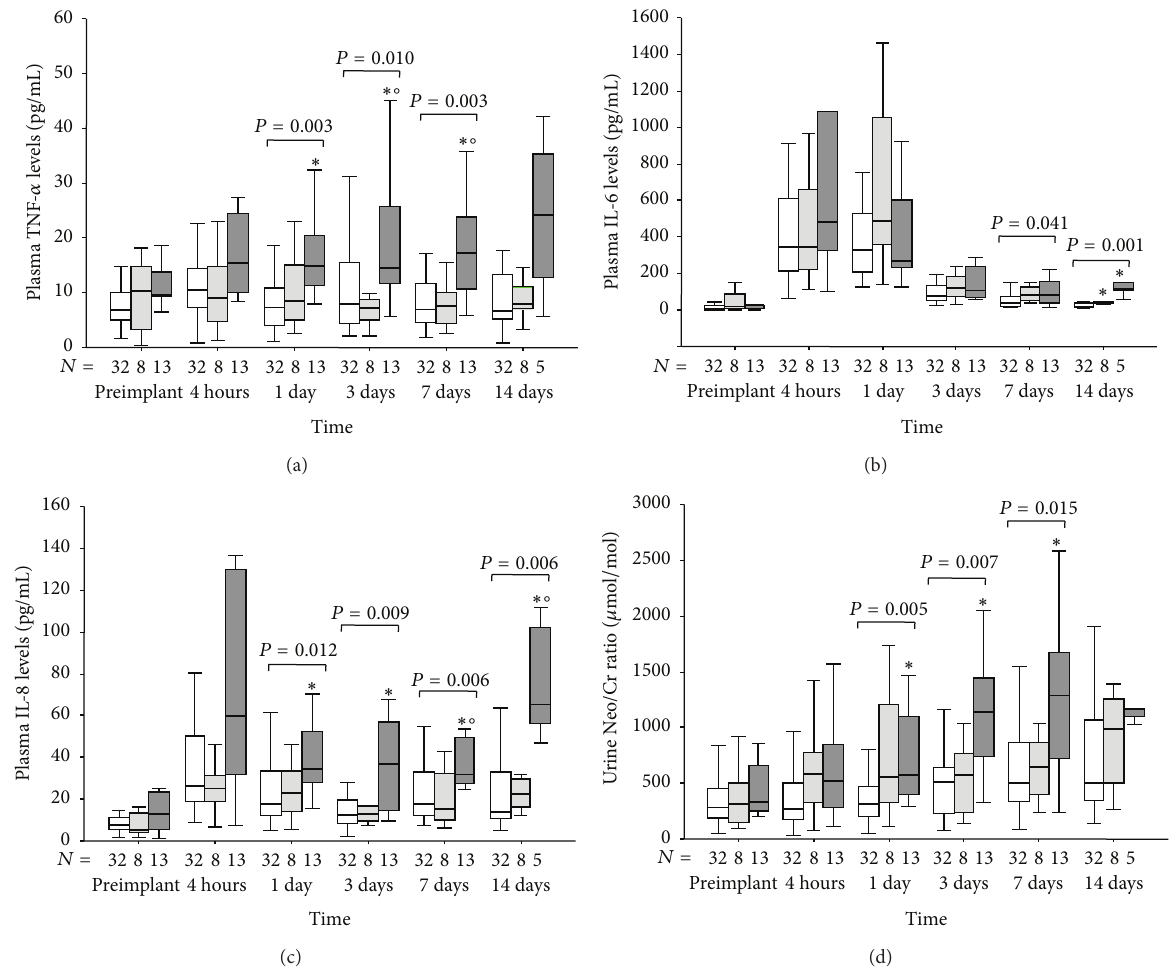
Figure 2: (a) Time course of plasma TNF- 𝛼 , (b) IL-6, (c) IL-8 levels, and (d) urine neopterin/creatinine ratio in patients that experienced postoperative maximal tSOFA score < 11 (group A: empty box-plots), and patients with postoperative maximal tSOFA score ≥ 11, with positive (group B: light gray box-plots) or negative (group C: dark gray box-plots) 3-month outcome. 𝑃 values are for differences among groups at each time-point by Kruskall-Wallis text. ∗ 𝑃 < 0.05 versus group A by Mann-Whitney text corrected by Bonferroni. ∘ 𝑃 < 0.05 versus group B by Mann-Whitney text corrected by